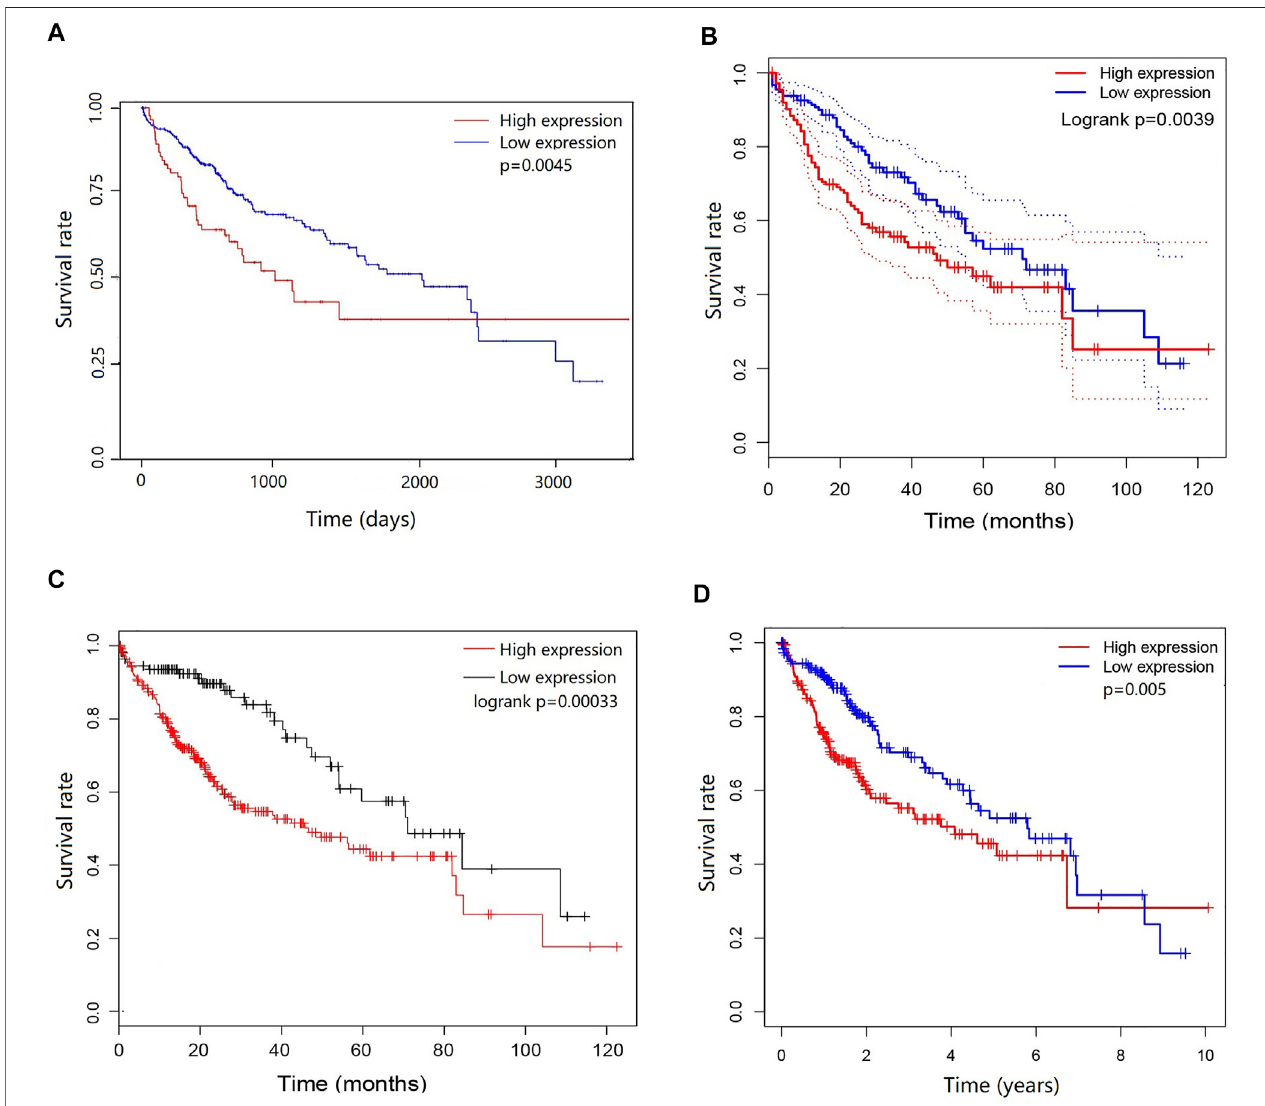
FIGURE 2 | Prognostic potential of DEPDC1B in LIHC. Four online tools were used to evaluate the relationships between DEPDC1B expression and patient survival. (A) OS in UALCAN database, the samples were divided into high DEPDC1B expression ( n (cid:1) 88) and low/medium DEPDC1B expression ( n (cid:1) 277) groups according to the median of DEPDC1B expression. p (cid:1) 0.0045 (B) OS in GEPIA database. The samples were divided into high DEPDC1B expression ( n (cid:1) 181) and low DEPDC1B expression ( n (cid:1) 181) groups according to the median of DEPDC1B expression. p (cid:1) 0.0039 (C) OS in Kaplan-Meier Plotter database. The number of patientsinhighandlowgroupswas252,112,respectively. p (cid:1) 0.00033 (D) OSinTCGAdatabase, p (cid:1) 0.005.ThesamplesweredividedintohighDEPDC1Bexpression ( n (cid:1) 260) and low DEPDC1B expression ( n (cid:1) 110) groups according to the median of DEPDC1B expression. p (cid:1) 0.005. OS: overall